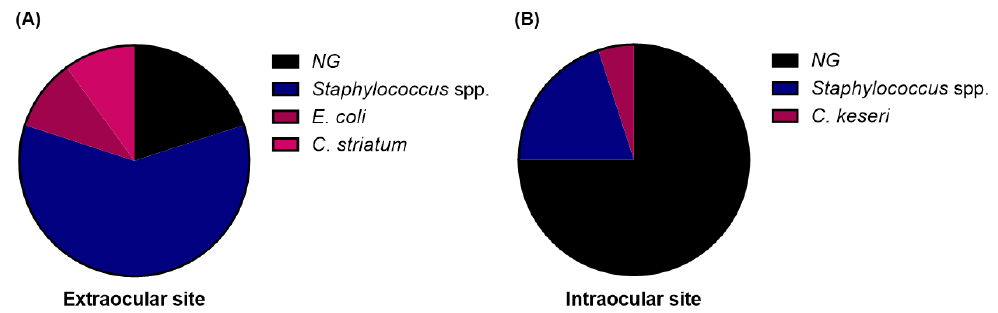
Figure 5. Comparison of undetected rate and abundance of detected microbial strains by sampling site at the extraocular and intraocular sides of the contaminated graft. ( A ) Extraocular side sampling revealed 12 cases (60%) of Staphylococcus spp., 2 cases (10%) of Escherichia coli, 2 cases (10%) of Corynebacterium striatum , and 4 undetected cases (20%). ( B ) Extraocular side sampling revealed 4 cases (20%) of Staphylococcus spp., 1 case (5%) of Citrobacter koseri , and 15 undetected cases (75%).